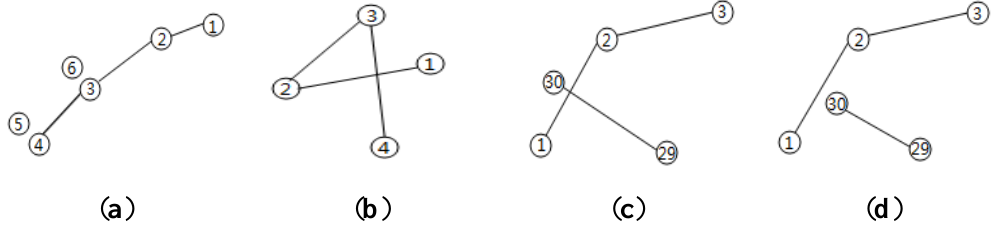
Figure 7. Some topological errors in OSM roads: ( a ) Redundancy; ( b ) Self-intersection; ( c ) Over-shoot; ( d )